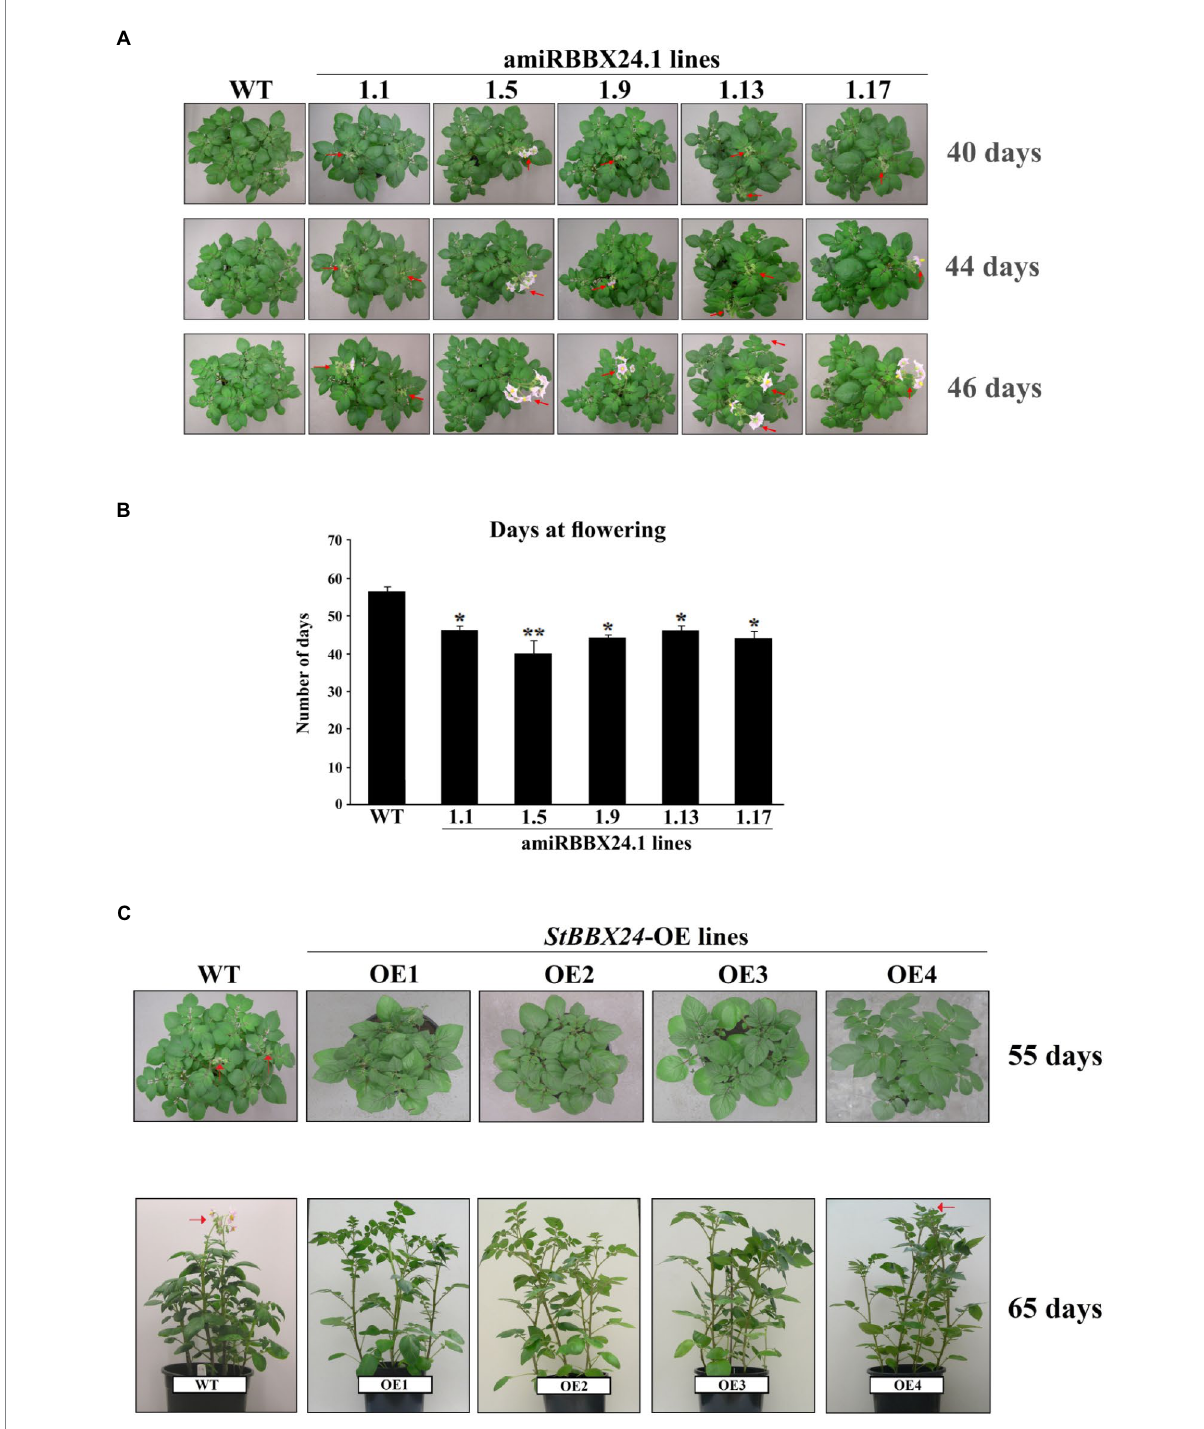
FIGURE 2 Flowering phenotype of S. tuberosum plants silenced for StBBX24 expression and overexpressing StBBX24 . (A) Phenotype of WT, amiRBBX24.1.1, amiRBBX24.1.5, amiRBBX24.1.9, amiRBBX24.1.13 and amiRBBX24.1.17 transgenic plants at the pre-flowering and flowering stages. Sixteen to twenty plugs from potato tubers per genotype were grown in plastic pots (diameter 21 cm) in the growth room in standard conditions under a 16-h photoperiod. The red arrows indicate the presence of flower buds and open flowers. (B) Number of days at flowering in WT and lines silenced for StBBX24 expression. * and **, values significantly different from the WT value ( t -test) with p < 0.05 and p < 0.01, respectively. WT, wild- type. (C) Phenotype of WT, StBBX24 -OE1, StBBX24 -OE2, StBBX24 -OE3 and StBBX24 -OE4 transgenic plants at the pre-flowering and flowering stages. Twenty plugs from potato tubers per genotype were grown in plastic pots (diameter 21 cm) in the growth room in standard conditions under a 16-h photoperiod. The red arrows indicate the presence of flower buds and open